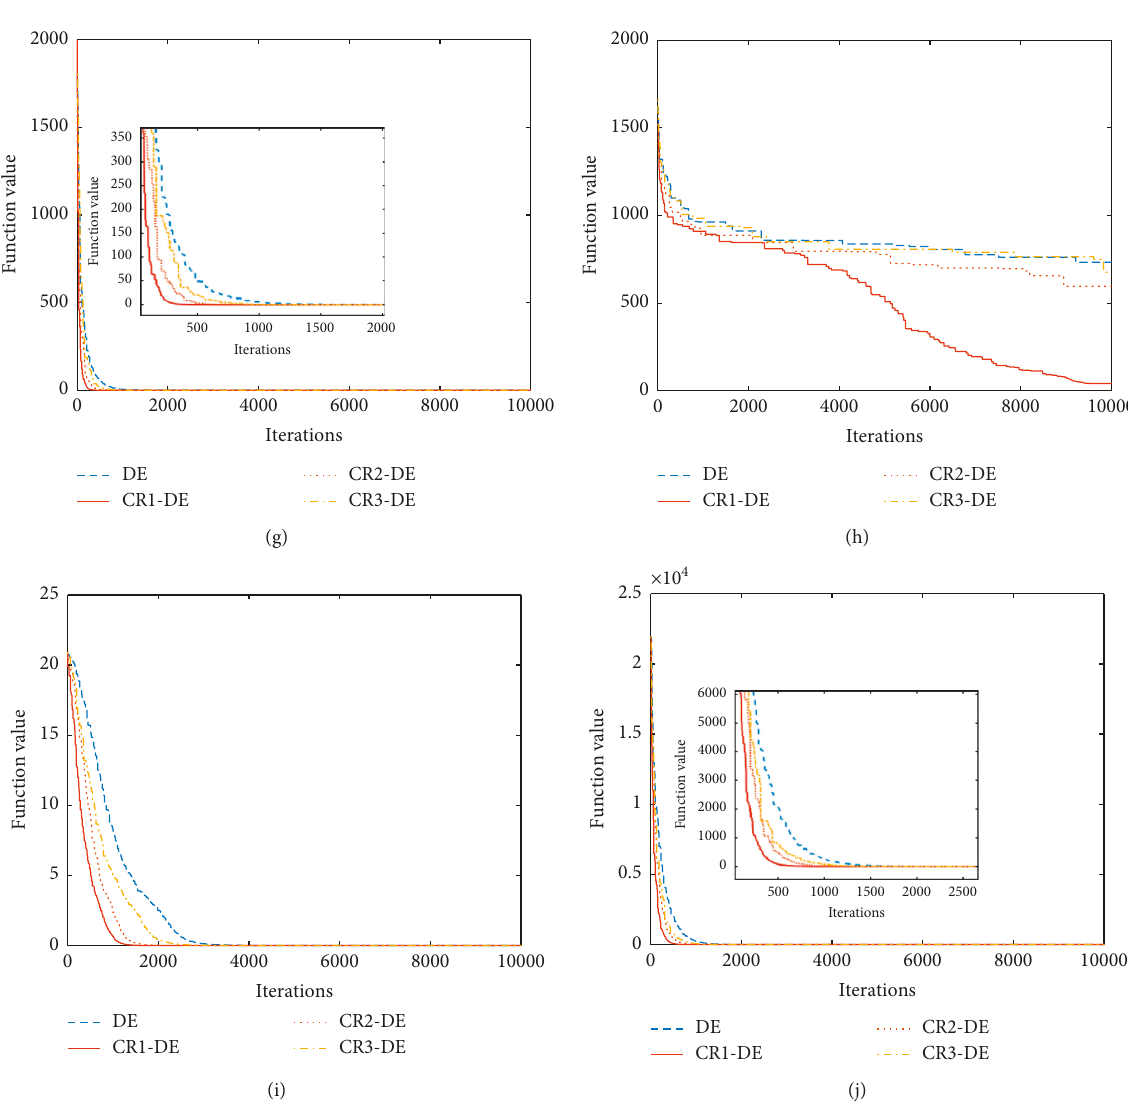
Figure 6: Convergence curves of f � 100 (if there are two figures in one subgraph, the smaller one represents partial enlarged 1 – f 10 when D drawing of the bigger one for clear presentation). (a) f 1 , (b) f 2 , (c) f 3 , (d) f 4 , (e) f 5 , (f) f 6 , (g) f 7 , (h) f 8 , (i) f 9 , and (j) f 10